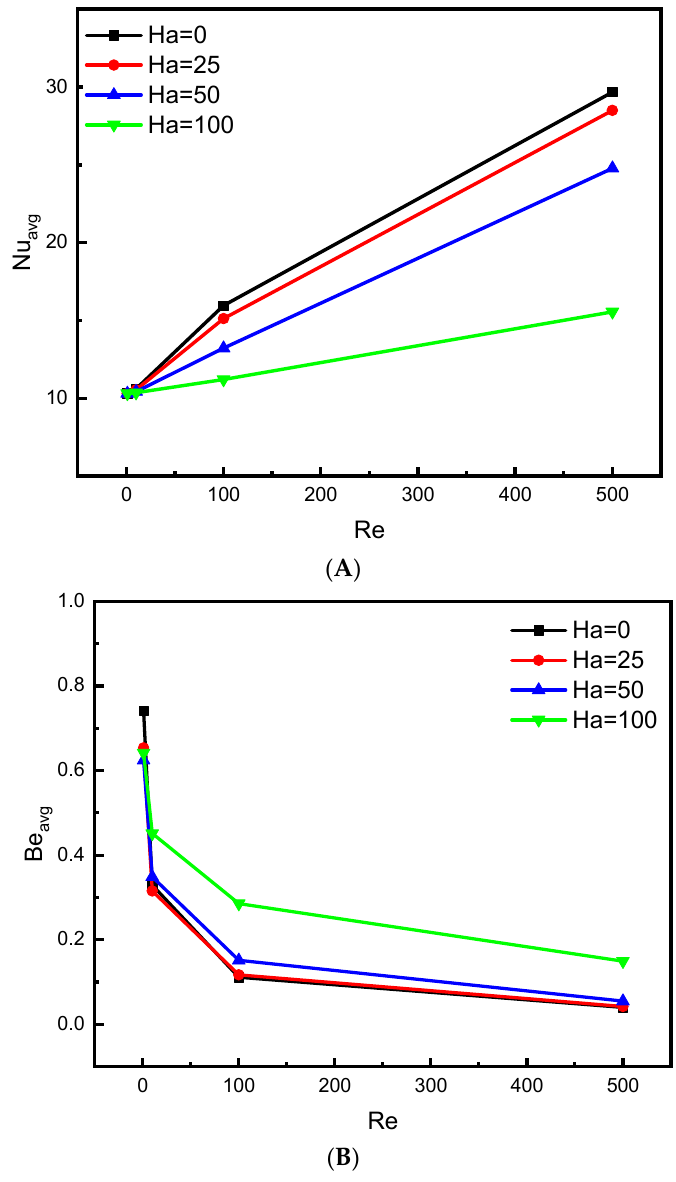
Figure 7. Influence of Ha on ( A ) Nu avg and ( B ) Be avg for Da = 10 − 2 and φ = 0.04. Figure 8A,B represents the effect of room permeability (Darcy number) on the mean values of the Nusselt and Bejan numbers for various values of Re at Ha = 0 and N = 4. It is clear that the higher value of the Darcy number (Da), the higher value of the Nusselt number (Nu), and this is mainly due to the increase in the permeability of the medium, which facilitates the movement of the flow, which makes the heat transfer process better. There is a slight regression of the values of the Bejan number in terms of the Darcy number. However, the influence of the Reynolds number on the Nu and Be numbers remains the same, as in the previous